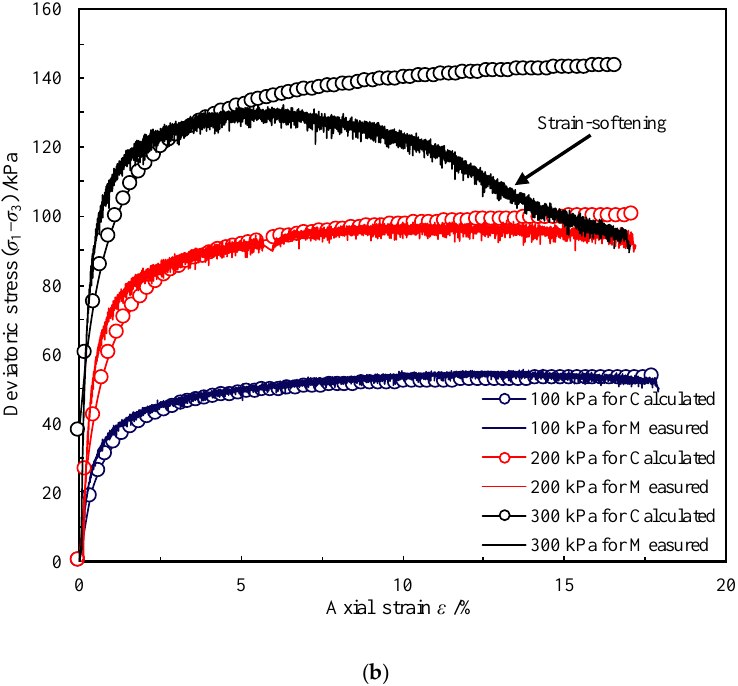
Figure 13. Predicted stress–strain curves with ( σ 1 − σ 3 ) adopted as normalized factor. ( a ) Normalized deviator stress-strain behaviour; ( b ) Deviatoric stress-strain behaviour.